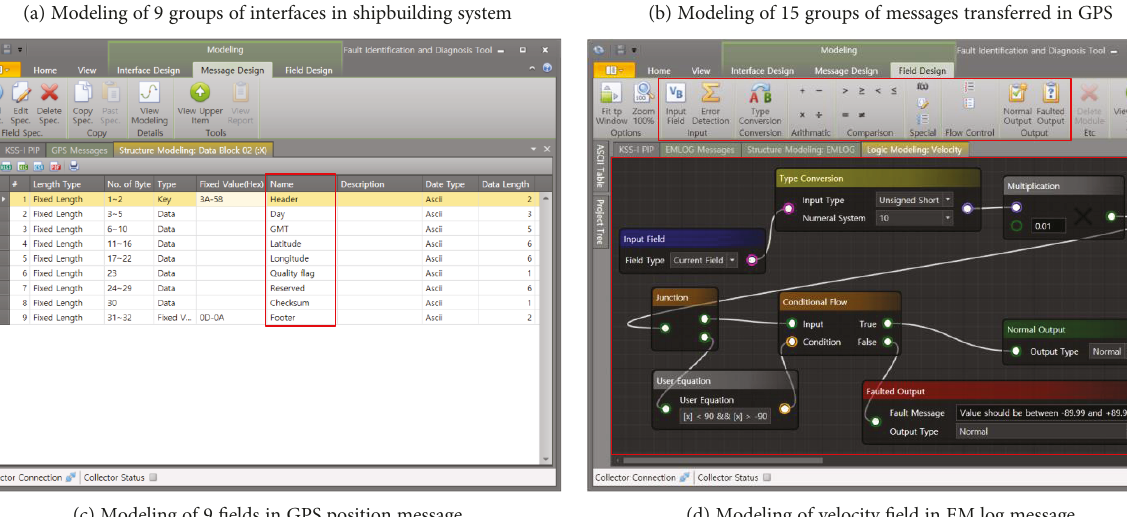
Figure 8: Interface data modeling using developed